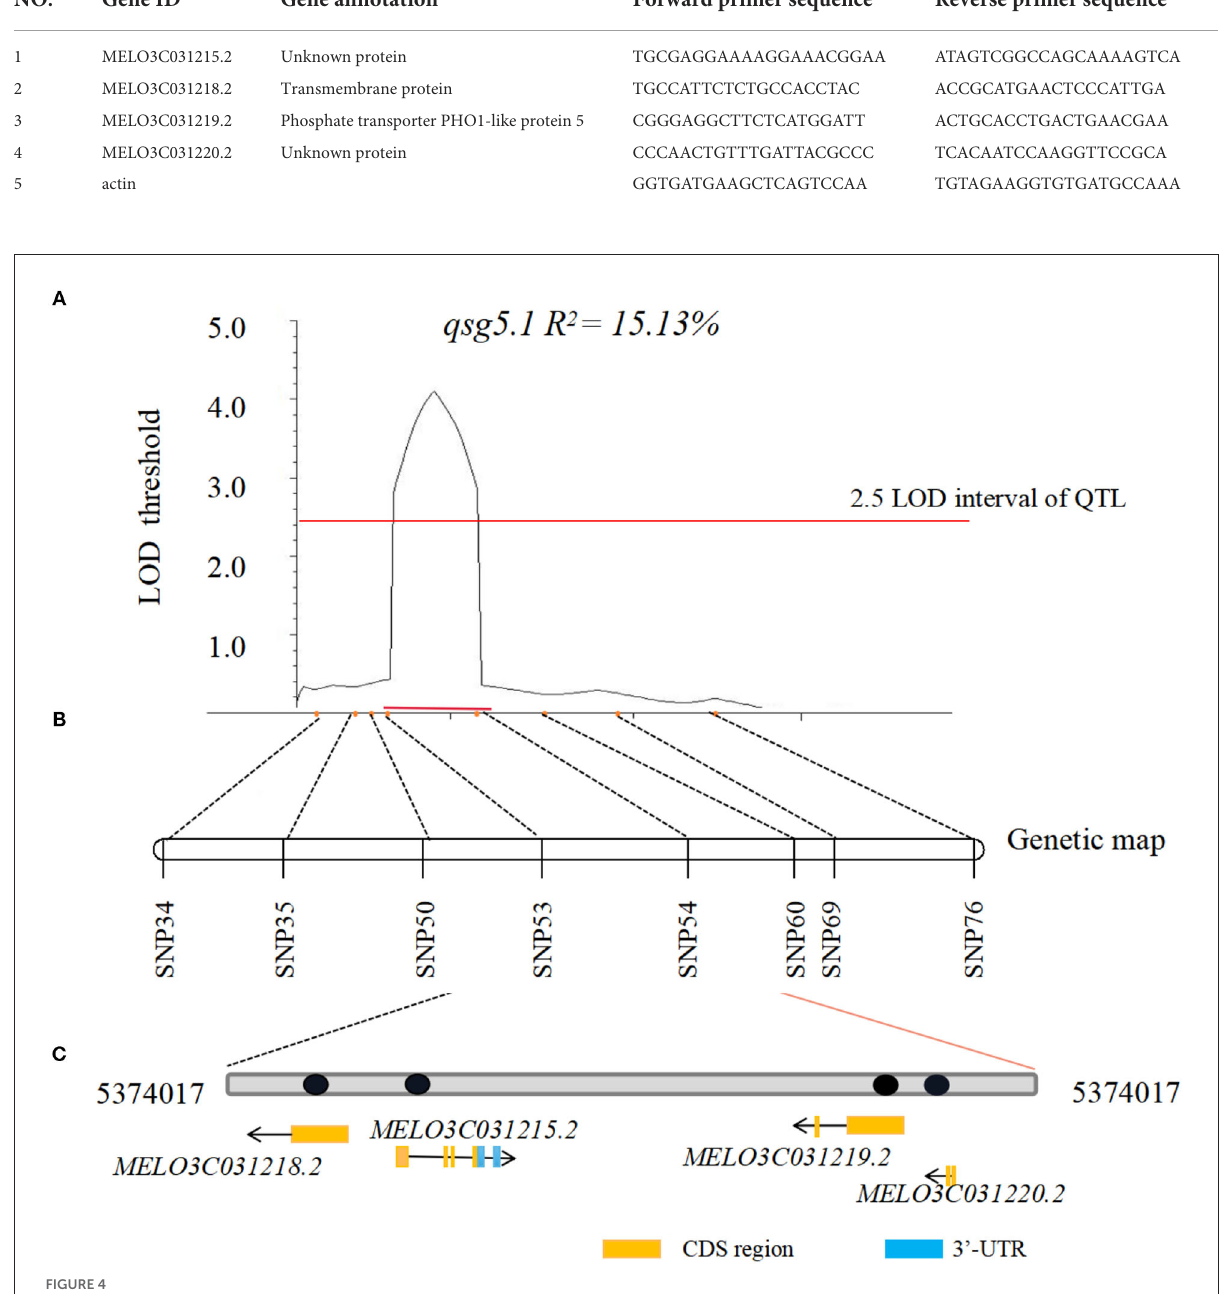
FIGURE4 LOD curves of QTL for seed germination detected in a large F 2 population. (A) Fine mapping based on consistent QTL qsg5.1 for seed germination rate was detected with 421 F 2 plants, and phenotype of each F 2 individual fruit of 2021 defined the candidate locus to a 33.83Kb region between markers SNP53 and SNP54. Horizontal dashed lines are LOD threshold values for declaring significant QTL. Horizontal red bars define 2.5 LOD interval of QTL. The percentage of phenotypic variations explained by each QTL (R 2 ) is shown. (B) Genetic map construction is based on preliminary SLAF-seq QTL region. (C) Candidate genes in interval region which contain four genes.